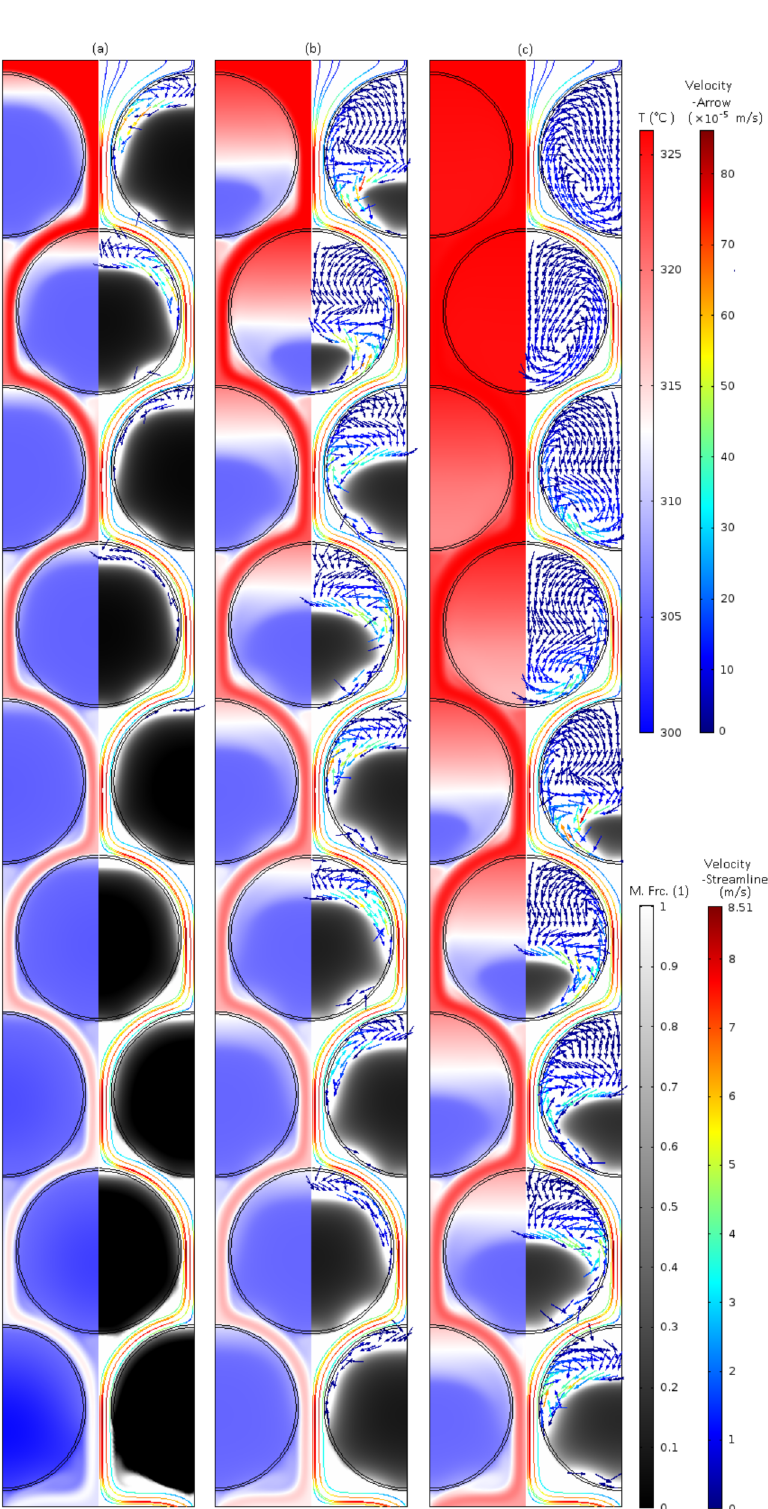
Fig. 4. Temperature, melt fraction and velocity distributions of the tank during charge mode at various stages: (a) 30 min, (b) 60 min, and (c) 90